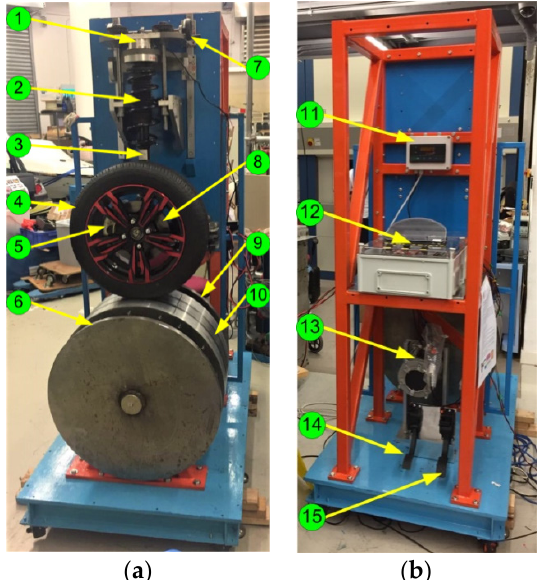
Figure 3. Prototype of developed single-wheel all-electric ABS test bench: ( a ) Front view; ( b ) Rear view.